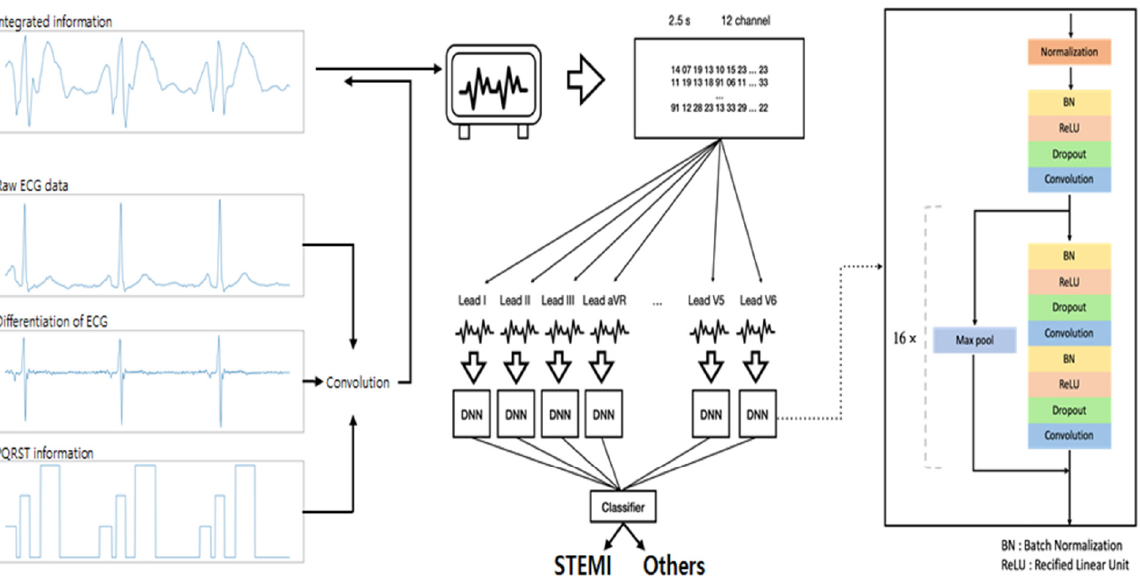
Figure 1. Model architecture of deep learning model. ECG, electrocardiogram; STEMI, ST elevation myocardial infarction; DNN, deep neural